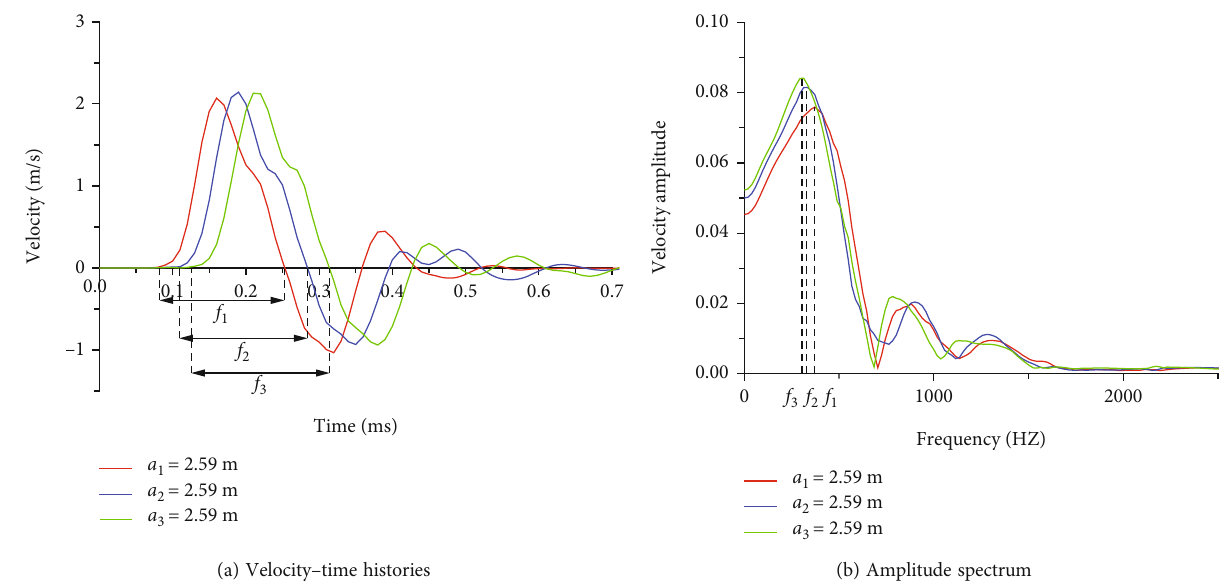
Figure 8: Waveforms and spectra of the elastic-plastic boundary under di ff erent charge